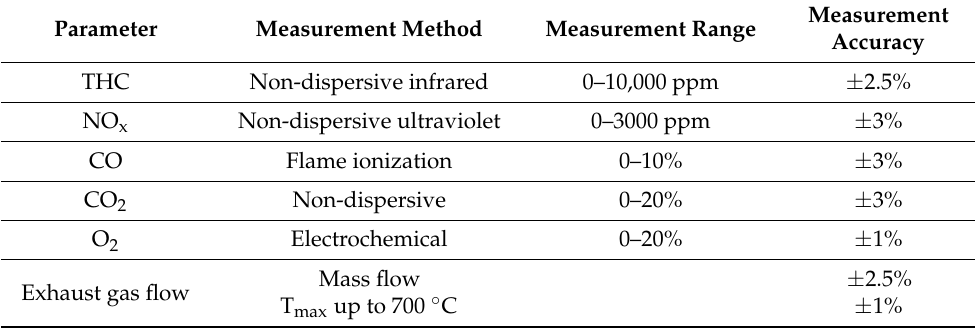
Figure 2. View of Semtech DS. Table 2. Semtech DS technical